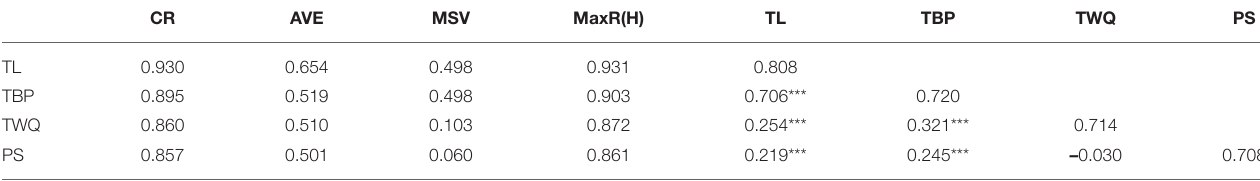
TABLE 2 | Model validity measures.